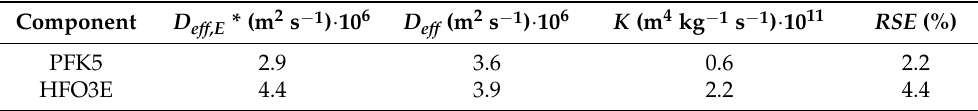
Table 6. Diffusion ( D eff , E and D eff ) and convective ( K ) coefficients and relative standard error ( RSE ) of the components of the ternary mixture after the optimization process in